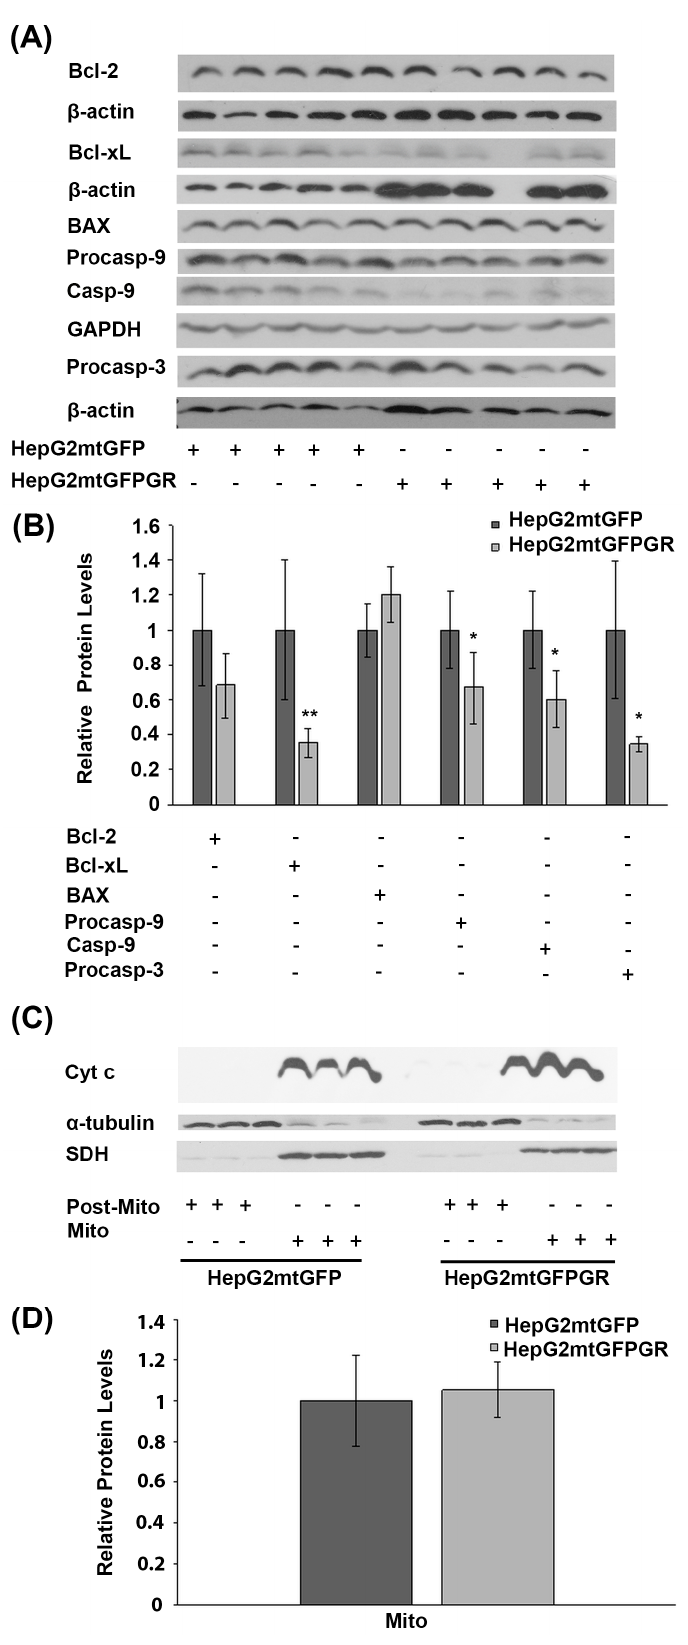
Figure 4. Assessment of the role of mtGR in the regulation of apoptosis, during tumor growth in human- to-mouse xenografts. ( A ) Western blot analysis of β -actin, glyceraldehyde 3-phosphate